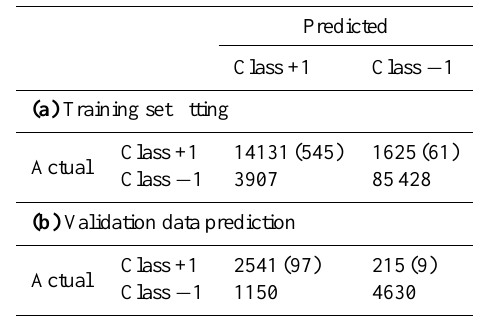
Table 4. SVM model: contingency tables for training and validation datasets. Numbers in brackets refer to real events.